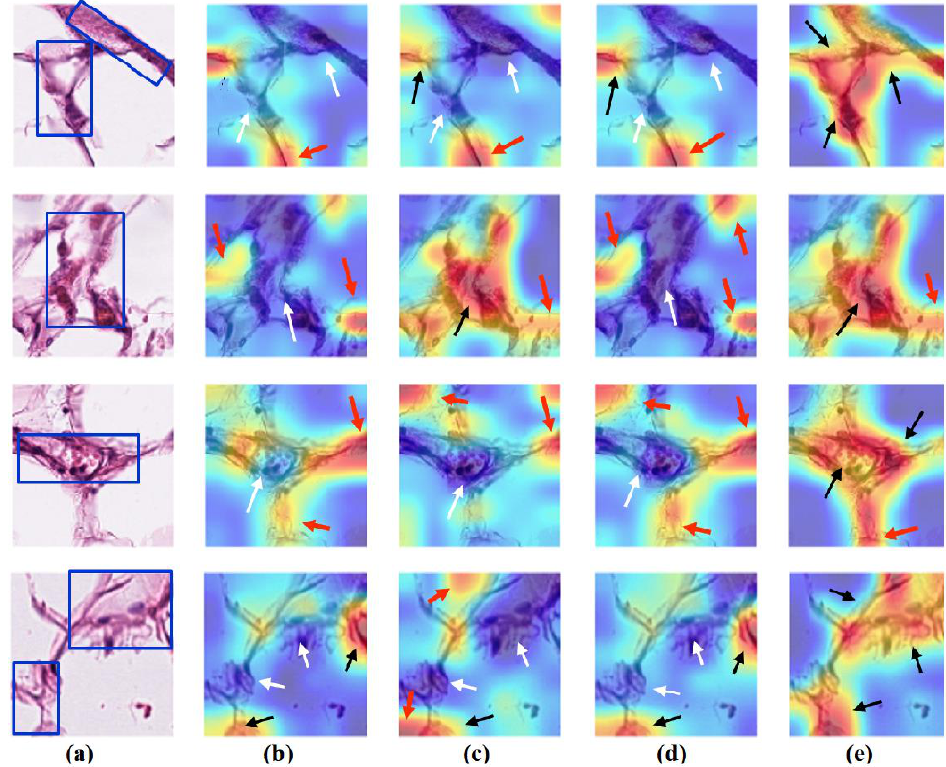
Figure 13. Visualisation of deep features for class ADI of CRC test set images obtained by each model: ( a ) original image with the region of interest covered in a blue rectangle, ( b ) ResNet-50 pre-trained network, ( c ) DeTraC, ( d ) 4S-DT , and ( e ) XDecompo